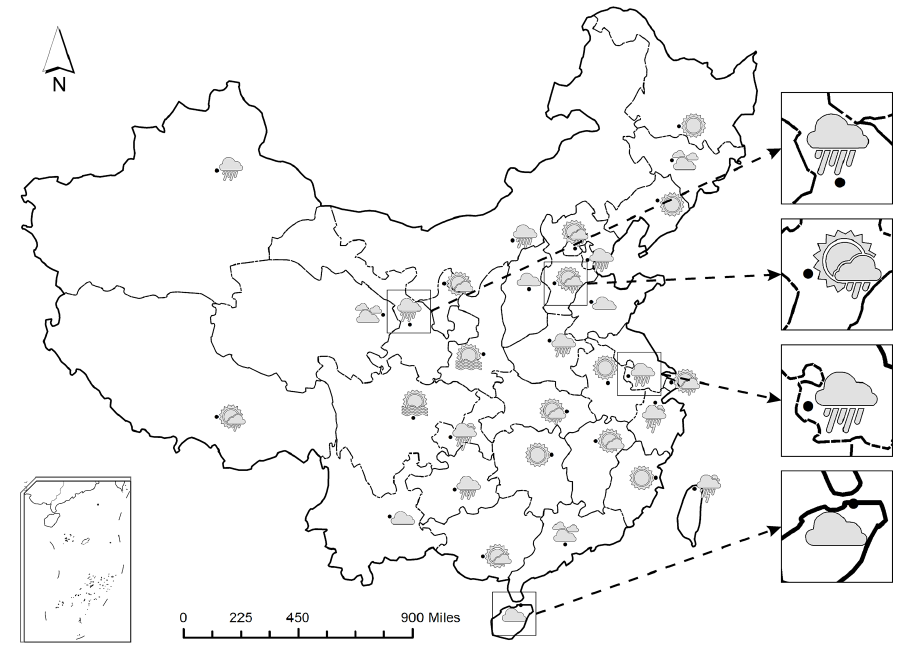
Figure 17. The labeling of weather condition symbols for the provincial capitals in China. And some representative labeling cases are